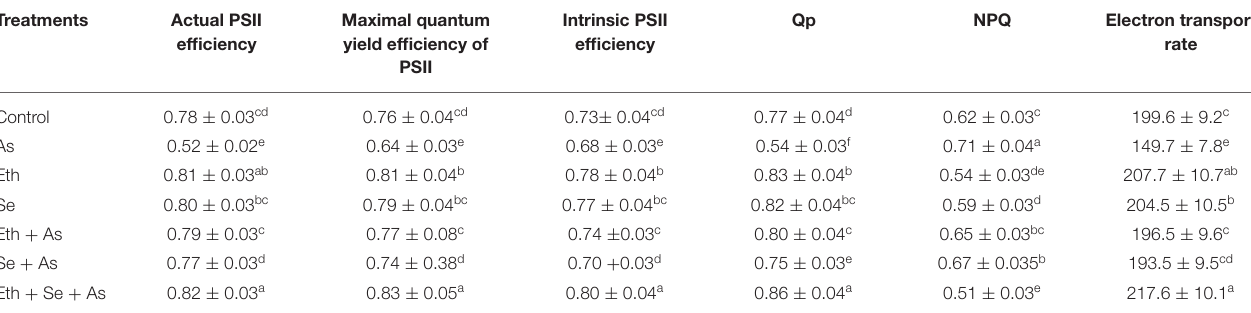
FIGURE 4 | In situ determination of generation of O − 2 by NBT (A – E) , H 2 O 2 by DAB (F – J) staining, respectively, of mustard ( B. juncea L.) at 30DAS. Plants were treated with control (A) and (F) ; As (B) and (G) ; Eth + As (C) and (H) ; Eth + Se (D) and (I) ; Eth + Se + As (E) and (J) . A single representative of each treatment is shown. As, arsenic; DAB, diaminobenzidine; Eth, ethephon; H 2 O 2, hydrogen peroxide; NBT, nitroblue tetrazolium; Se, selenium.